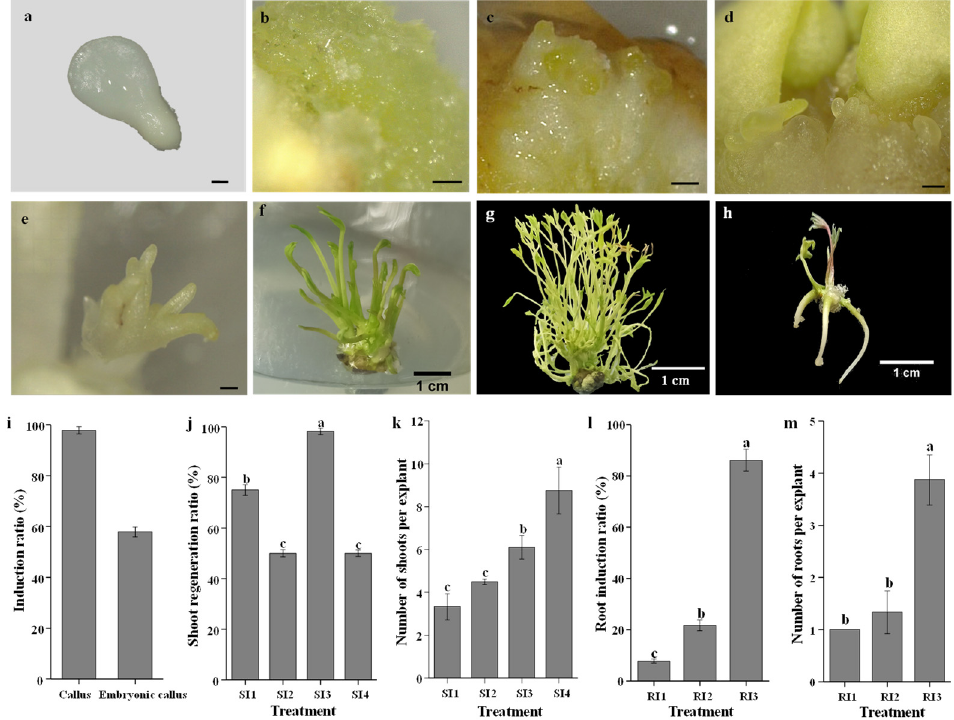
Figure 1. Whole process of plant regeneration via somatic embryogenesis and the related indexes. ( a ) Zygotic embryo explant (S0), ( b ) Non-embryonic callus (S1), ( c ) Embryonic callus (S2), ( d ) Somatic embryos (S3), ( e – g ) The regenerated shoots (S4), ( h ) The regenerated roots, ( i ) Induction ratio of callus and embryonic callus, ( j ) Shoot regeneration ratio in different treatments, ( k ) Number of shoots per explant in different treatments, ( l ) Root induction ratio in different treatments, ( m ) Number of roots per explant in different treatments. Scale bar of ( a – e ) is 500 µ m and scale bar of ( f – h ) is 1 cm. Different lowercase letters in ( i – m ) indicate significant differences among treatments (Duncan’s test at p < 0.05 after analysis of variance). The medium in ( a – d ) is WPM + 4.0 mg · L − 1 phytagel + 30 g · L − 1 sucrose + 3.0 mg · L − 1 6-BA and 1.0 mg · L − 1 NAA; the medium for shoot development in ( e – g ) is SI1–4, SI1 (WPM + 4.0 mg · L − 1 phytagel + 30 g · L − 1 sucrose + 0.5 mg · L − 1 6-BA + 0.5 mg · L − 1 GA 3 ); SI2 (WPM + 4.0 mg · L − 1 phytagel + 30 g · L − 1 sucrose + 0.5 mg · L − 1 6-BA + 1.0 mg · L − 1 GA 3 ); SI3 (WPM + 4.0 mg · L − 1 phytagel + 30 g · L − 1 sucrose + 1.0 mg · L − 1 6-BA + 0.5 mg · L − 1 GA 3 ); SI4 (WPM + 4.0 mg · L − 1 phytagel + 30 g · L − 1 sucrose + 1.0 mg · L − 1 6-BA + 1.0 mg · L − 1 GA 3 ); and the medium for root induction in ( h ) is RI1-3. RI1 (WPM + 4.0 mg · L − 1 phytagel + 30 g · L − 1 sucrose + 3.0 mg · L − 1 6-BA +3.0 mg · L − 1 IBA + 2.0 mg · L − 1 caffeic acid), RI2 (WPM + 4.0 mg · L − 1 phytagel + 30 g · L − 1 sucrose + 3.0 mg · L − 1 6-BA +3.0 mg · L − 1 IBA + 1.0 mg · L − 1 acetylsalicylic acid), RI3 (WPM + 4.0 mg · L − 1 phytagel + 30 g · L − 1 sucrose + 3.0 mg · L − 1 6-BA + 2.0 mg · L − 1 IBA + 1.0 mg · L − 1 acetylsalicylic